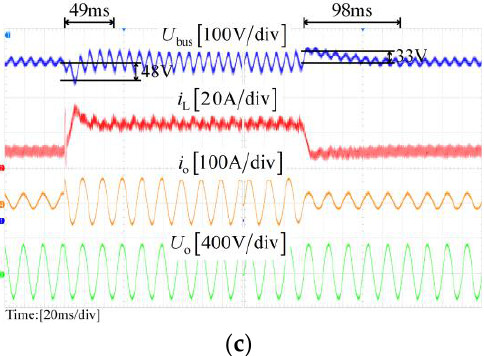
Figure 16. Dynamic experimental results between 33% and 100% full load. ( a ) Scheme I; ( b ) scheme II; ( c ) proposed NICFPS.